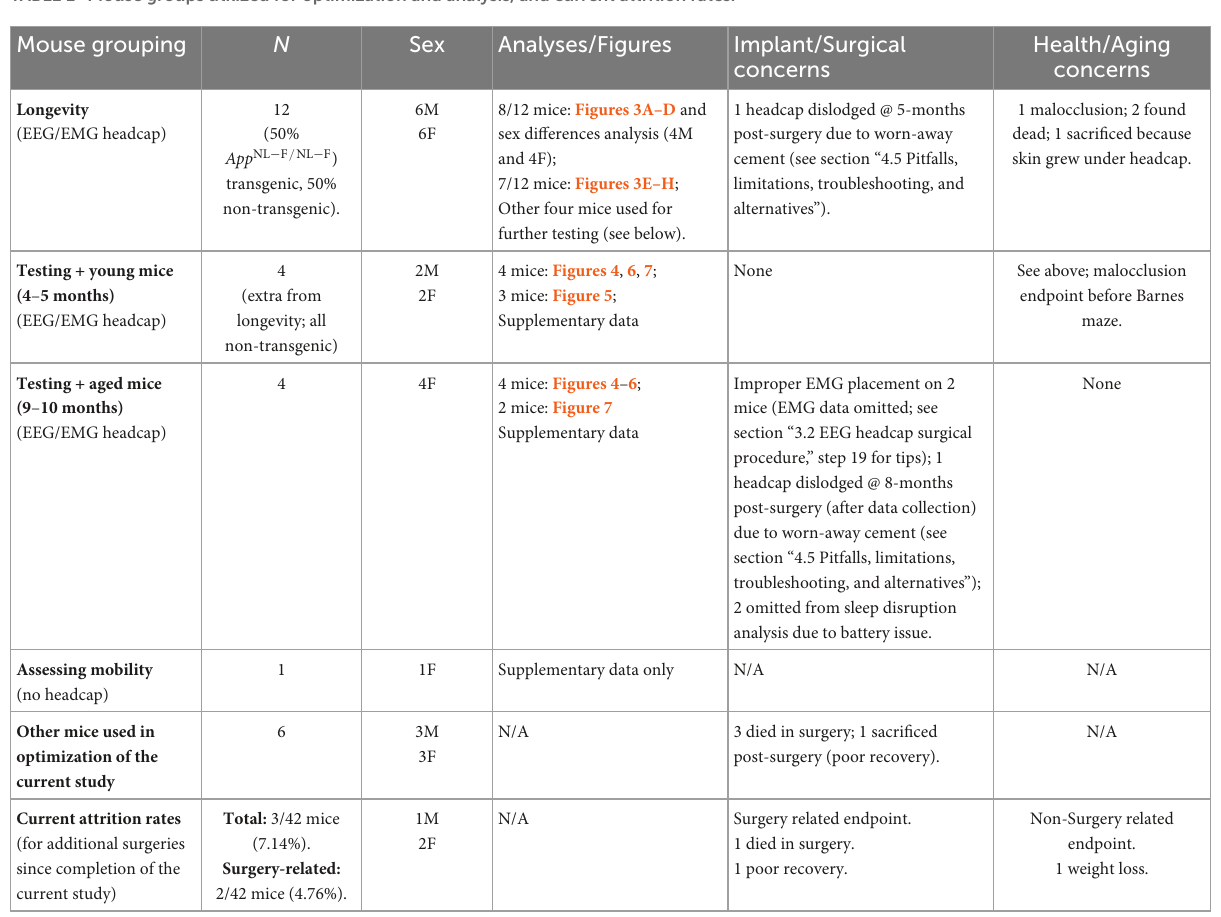
TABLE 1 Mouse groups utilized for optimization and analysis, and current attrition rates.